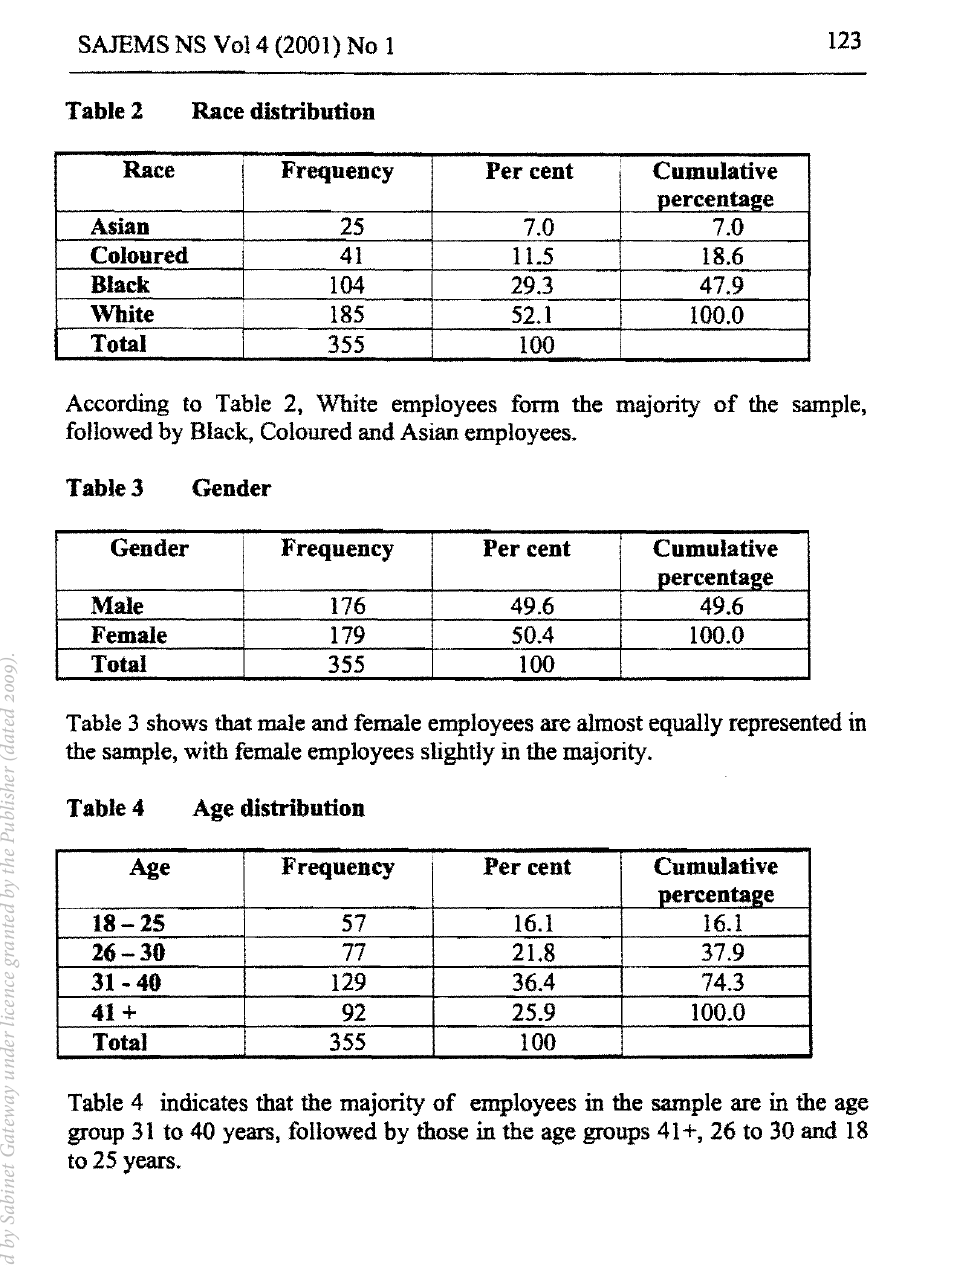
followed by Black, Coloured and Asian employees.